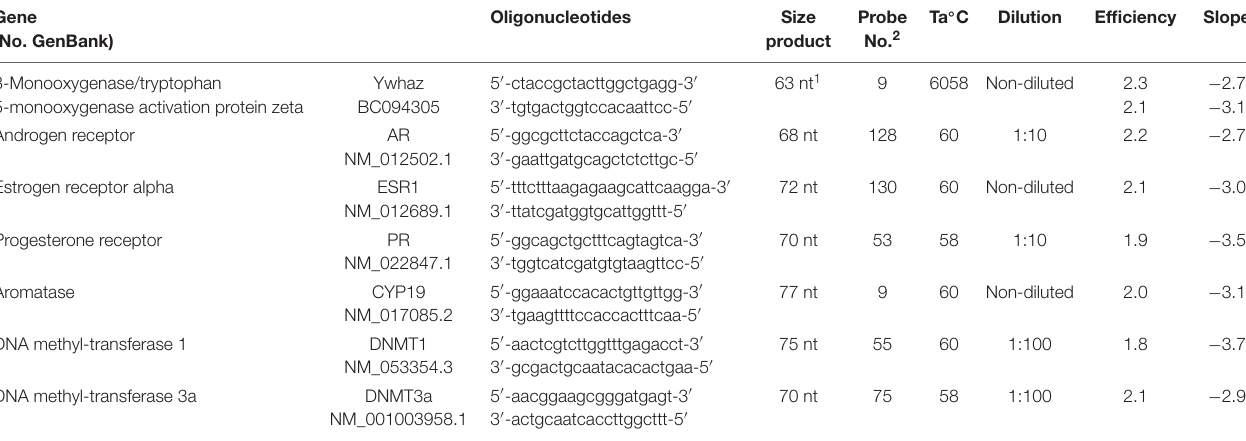
TABLE 1 | PCR probe sequences and amplification